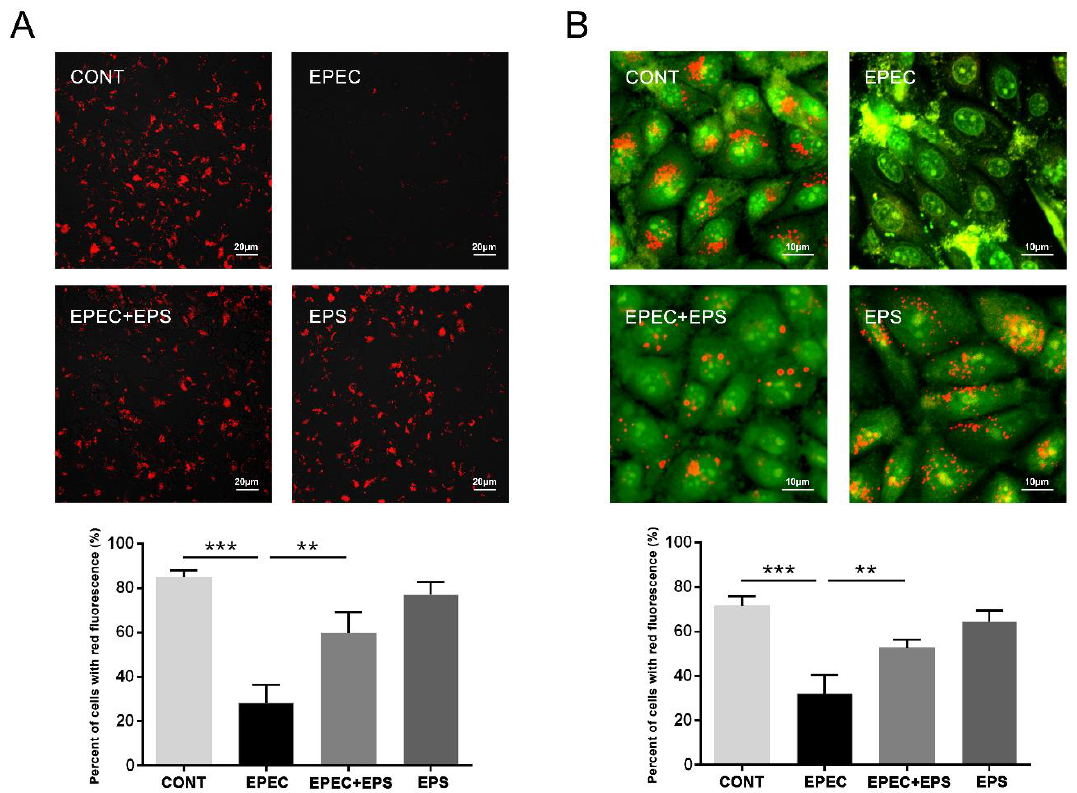
Figure 4. EPS resisted lysosomal alkalization caused by EPEC. ( A ) Lyso-Tracker Red staining was used to assess the lysosome acidity in IPEC-J2 cells. Scale bars, 20 µ m. The panel below was the percentage of cells with red fluorescence by Image J software. ( B ) Acridine orange staining was also used to assess the lysosome acidity in IPEC-J2 cells. Scale bars, 10 µm. The panel below was the percentage of cells with red fluorescence by Image J software. The data was presented as mean ± SEM ( n = 3), ** p < 0.01, *** p < 0.001.